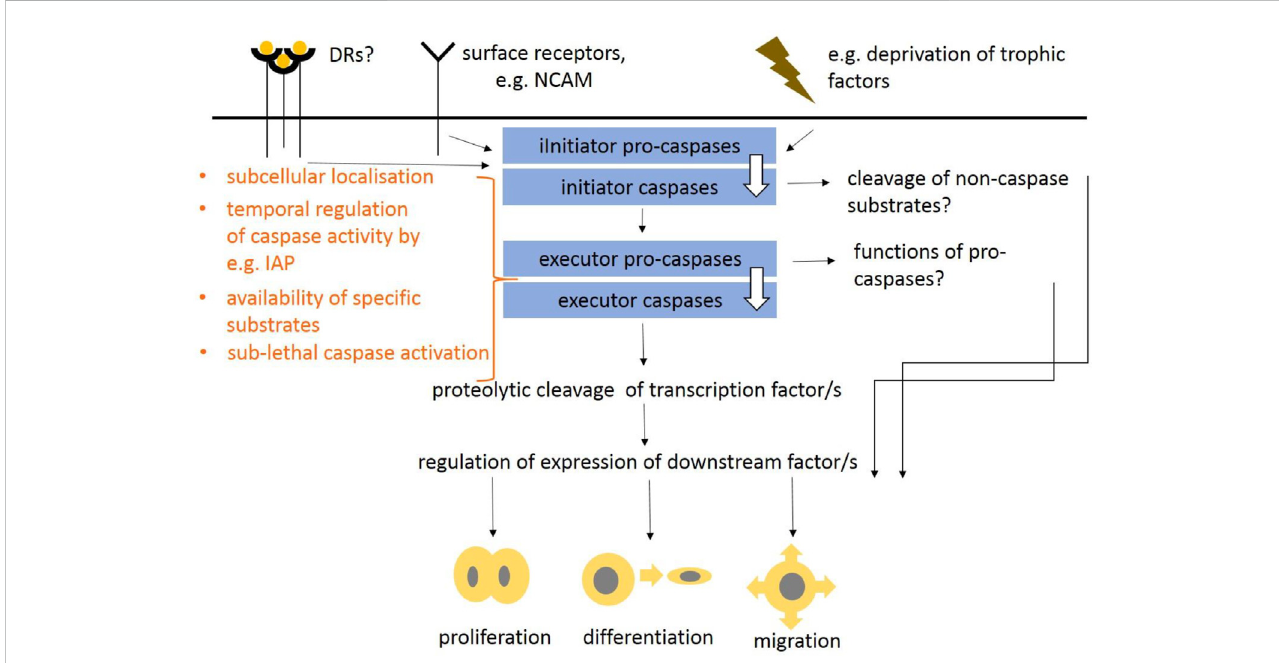
Putative schema suggesting non-lethal functions of caspases in intracellular signaling as proposed in Miura et al. (2004), Fujita et al. (2008), and Cusack etal.(2013).Non-apoptoticfunctionsofcaspasesmaybeinduced via deathreceptors,surfacereceptors(e.g.,NCAM)orinternalevents,suchasdeprivationof trophic factors. This results in activation of various initiator caspases and potentially also executor caspases. The mechanisms regulating lethal vs. non-lethal events may reside in caspase subcellular localisation, availability of different substrates, temporal caspase activation or sub-lethal caspase activation. Functions of pro-caspases and proteolytic cleavage of non-caspase substrates is questionable. These regulations may result in proliferation, migration and differentiation of